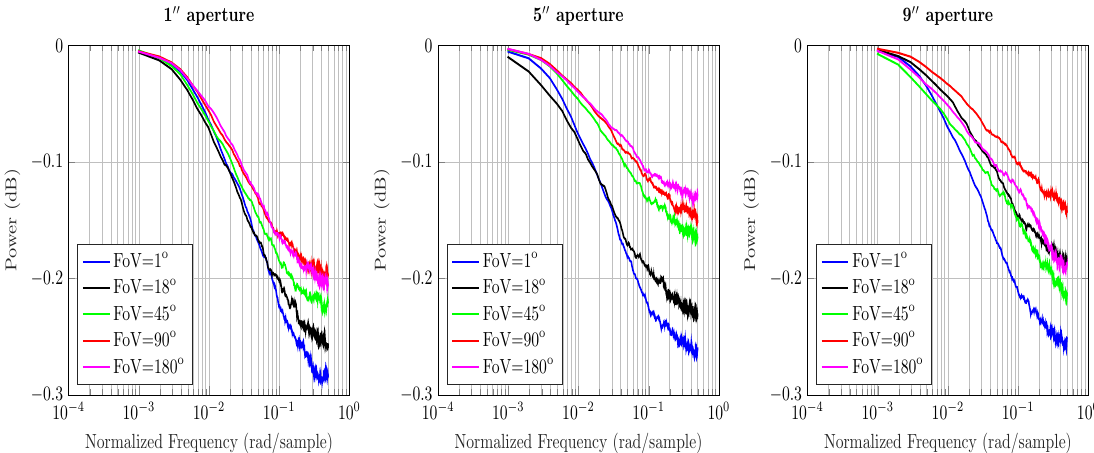
Figure 3. Comparison of the magnitude response of ocean water under various aperture sizes and FoVs for a 3 m LoS link.